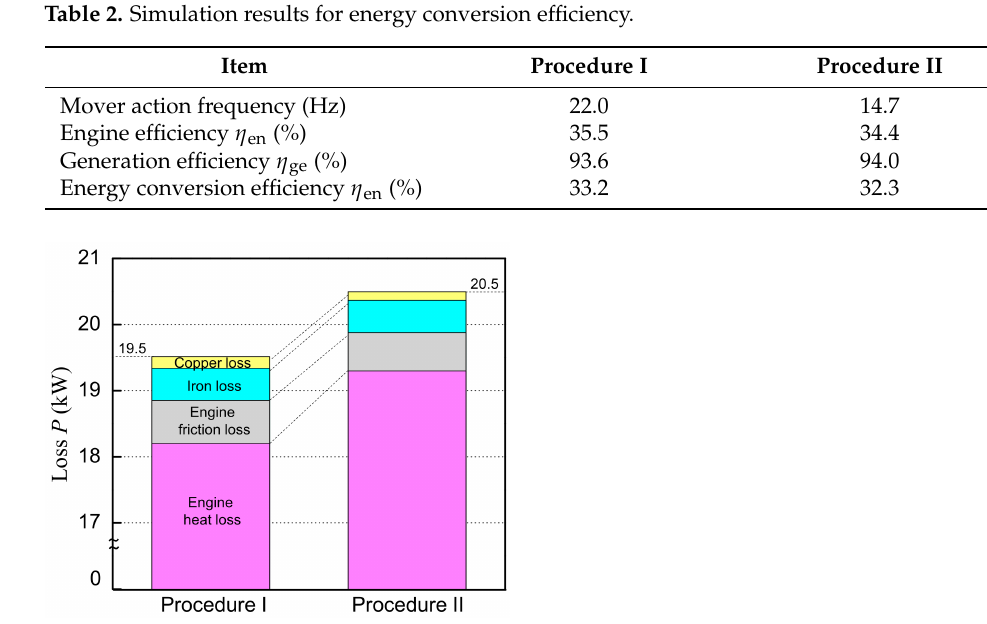
Figure 13. Simulation results of